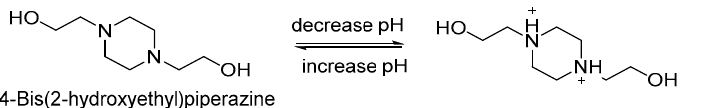
Scheme 3. Protonation of amino groups in HEP when pH is decreased in an acidic medium.